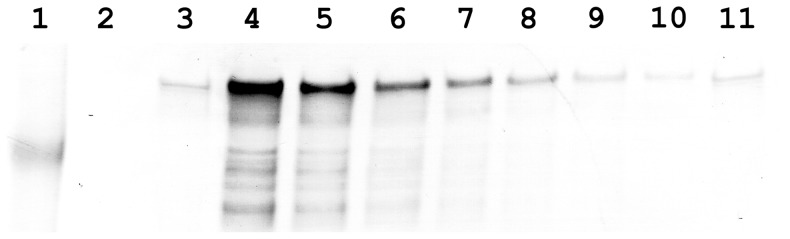
Overexpression of NhhA.Whole cell lysates were separated on 3–8% Tris-Acetate buffered PAGE, transferred to nitrocellulose, and immunoblotted with rabbit polyclonal anti-NhhA sera. Lane 1 Benchmark Prestained Marker, approximately 180 kDa marker indicated. Lane 2, 25 µg protein of strain 2A (NhhA expression abolished); Lanes 3 and 11, 25 µg protein of strain 7G2 (parental strain expressing wild type levels of NhhA), Lane 4, 25 µg protein of strain P6ΔOpcA. Lane 5, 12.5 µg protein of strain P6ΔOpcA; Lane 6, 6.25 µg protein of strain P6ΔOpcA; Lane 7 3.125 µg protein of strain P6ΔOpcA; Lane 8, 1.56 µg protein of strain P6ΔOpcA; Lane 9, 0.78 µg protein of strain P6ΔOpcA; Lane 10, 0.39 µg protein of strain P6ΔOpcA.